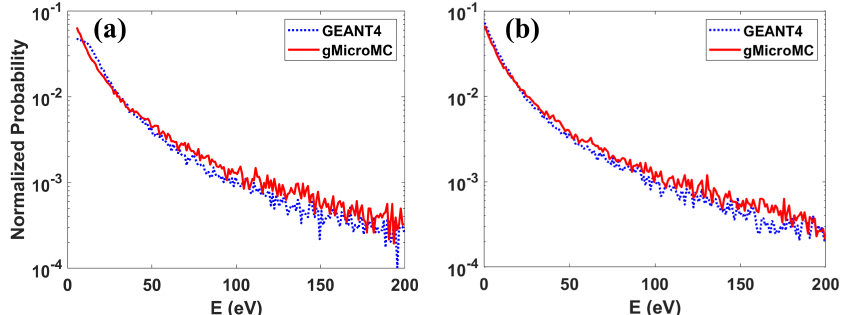
Figure 3. Secondary electron spectrum for ( a ) a 5 MeV proton and ( b ) a 4 MeV alpha particle.